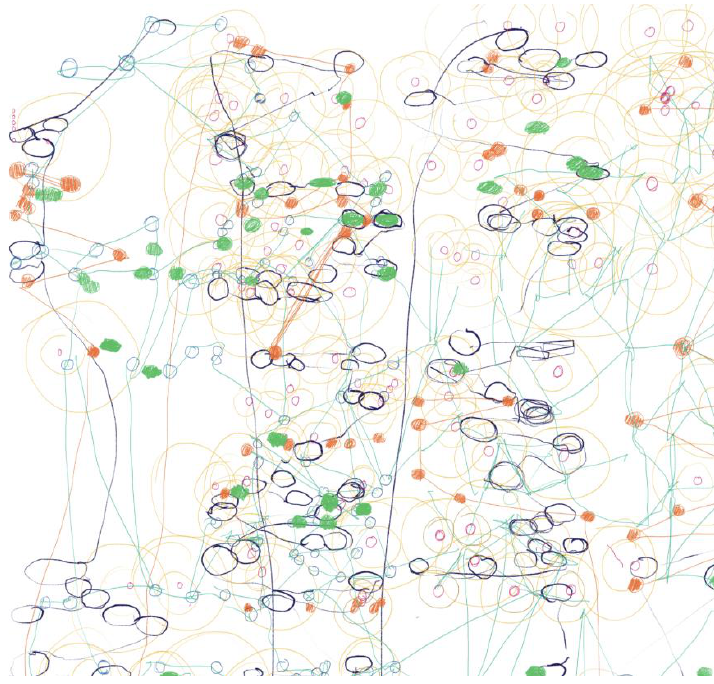
Figure 7 : Thinking-through